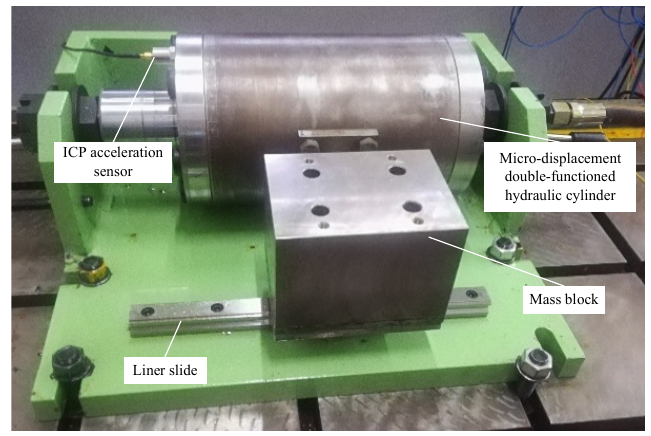
Figure 38. Prototype model of the hydraulic controlled rotary valve. Energies 2018 , 11 , x FOR PEER REVIEW